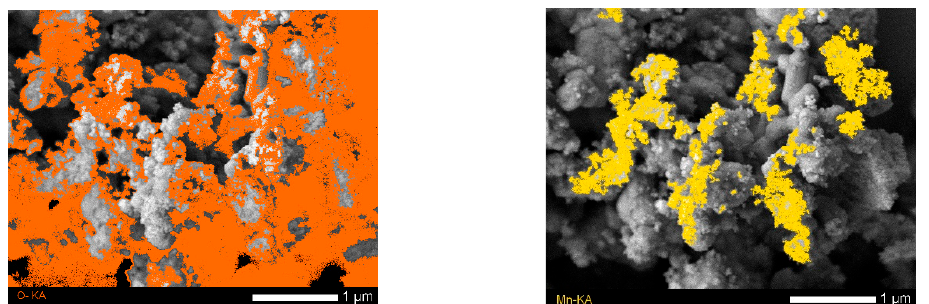
Figure 14. Mapping results for 0.7FeCeO x + 0.3 Nb 2 O 5 nanoparticles after filtration. (The color in the figure indicates the distribution of elements determined according to the mapping data: red — Fe, green — Ce, blue — Nb, orange — O, and yellow — Mn.)